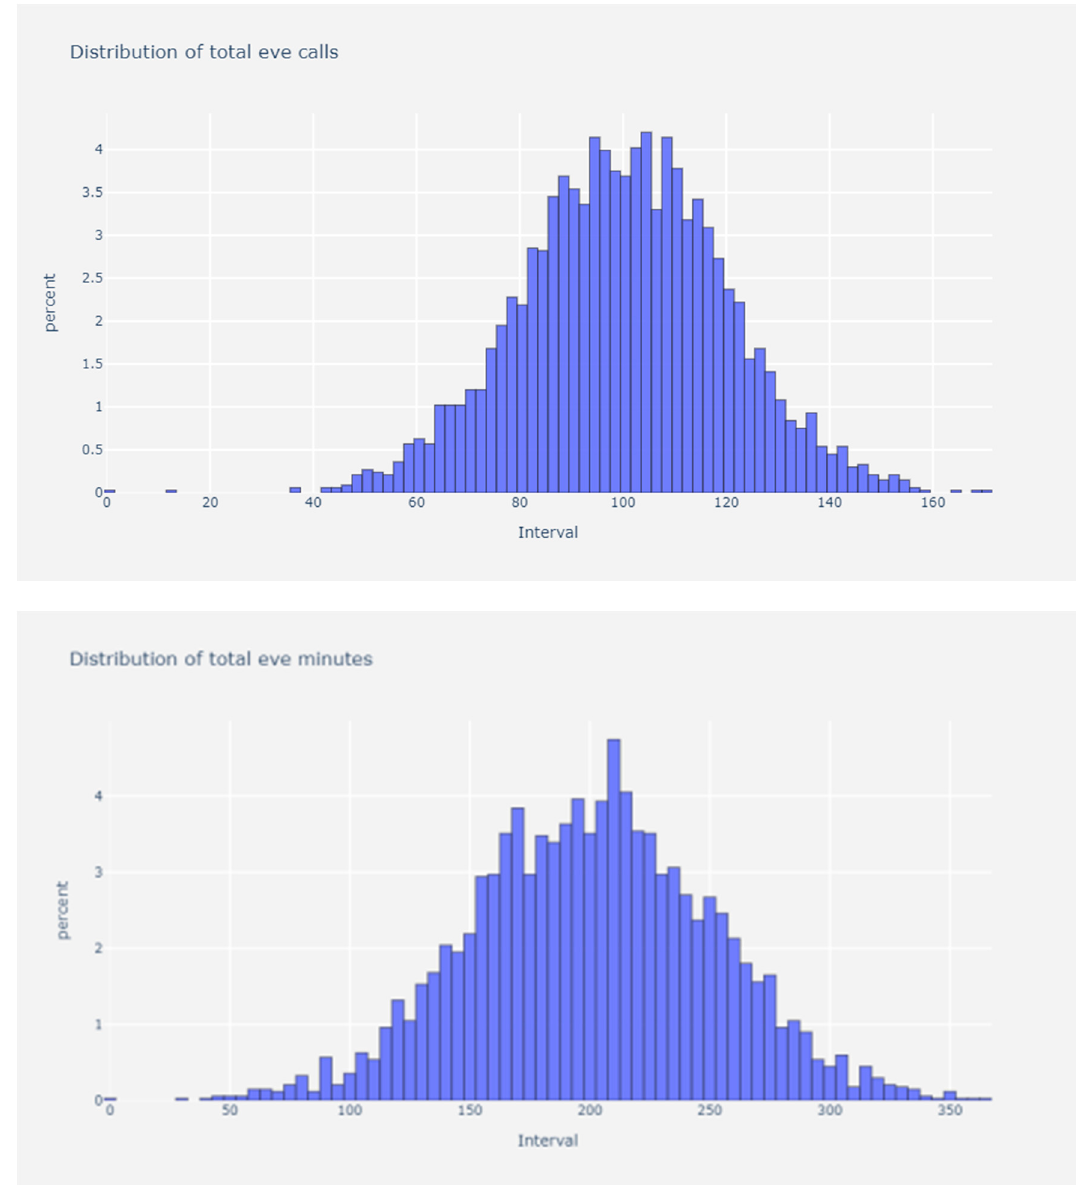
Figure 3. Histograms for data distributions of 4 features.